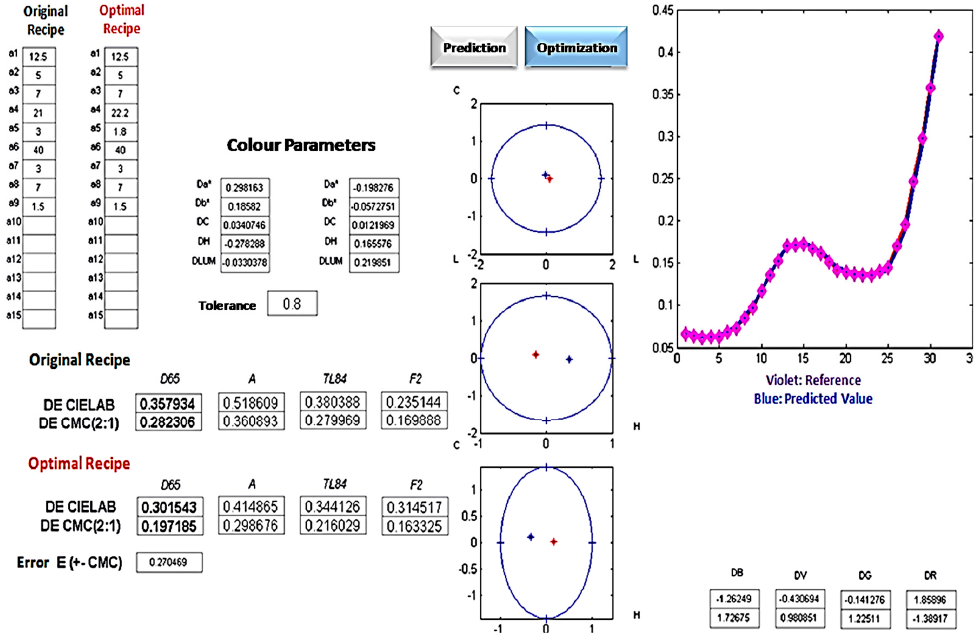
Figure 5. System used for laboratory testing [1] implementing algorithms proposed in [8].